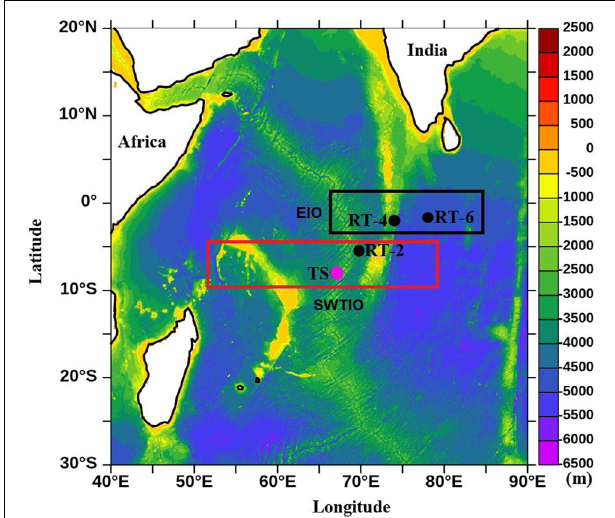
FIGURE 1 | Study area map showing the four sampling locations. The black and pink dots indicate return track (RT) and time series (TS) stations; red and black rectangle denotes the southwest tropical Indian Ocean (SWTIO) and equatorial Indian Ocean (EIO) region, respectively. Background colors indicate the bathymetry derived from ETOPO